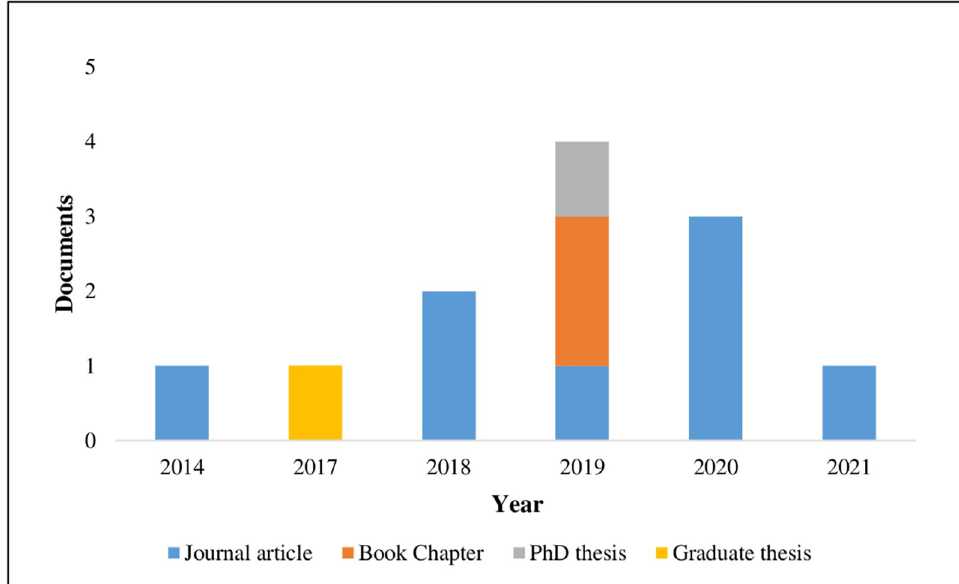
Fig 3. Distribution of the published reviews over time and by study